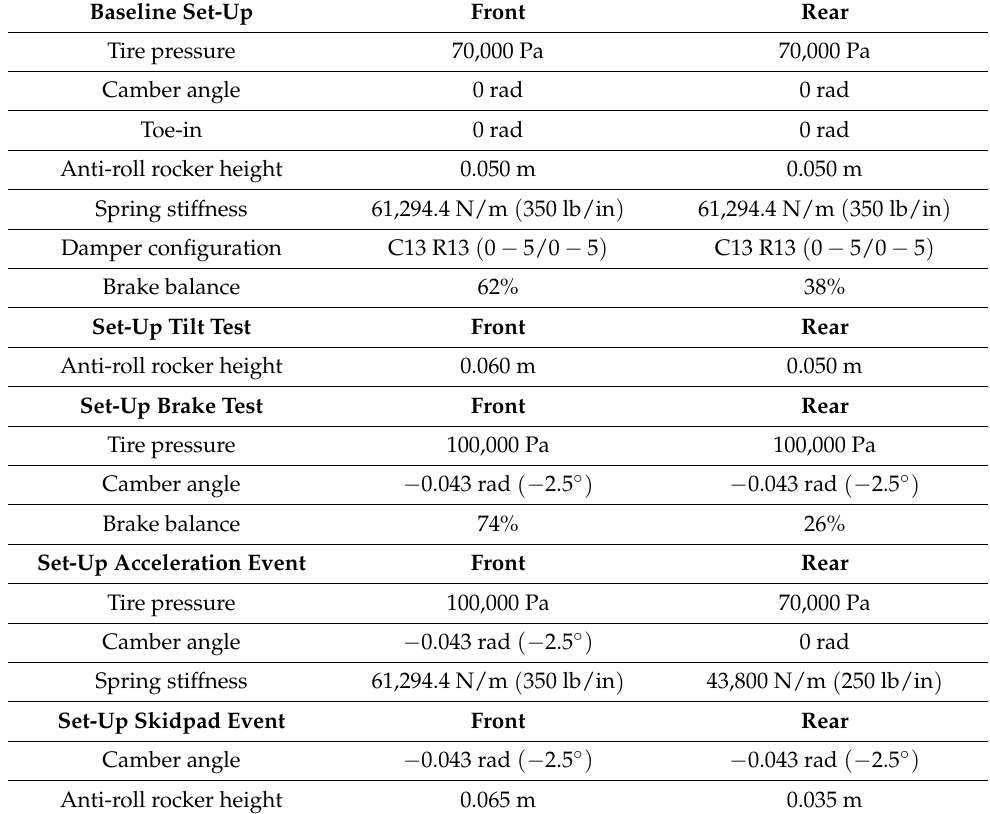
Table 3. Baseline contrasted with fine-tuned